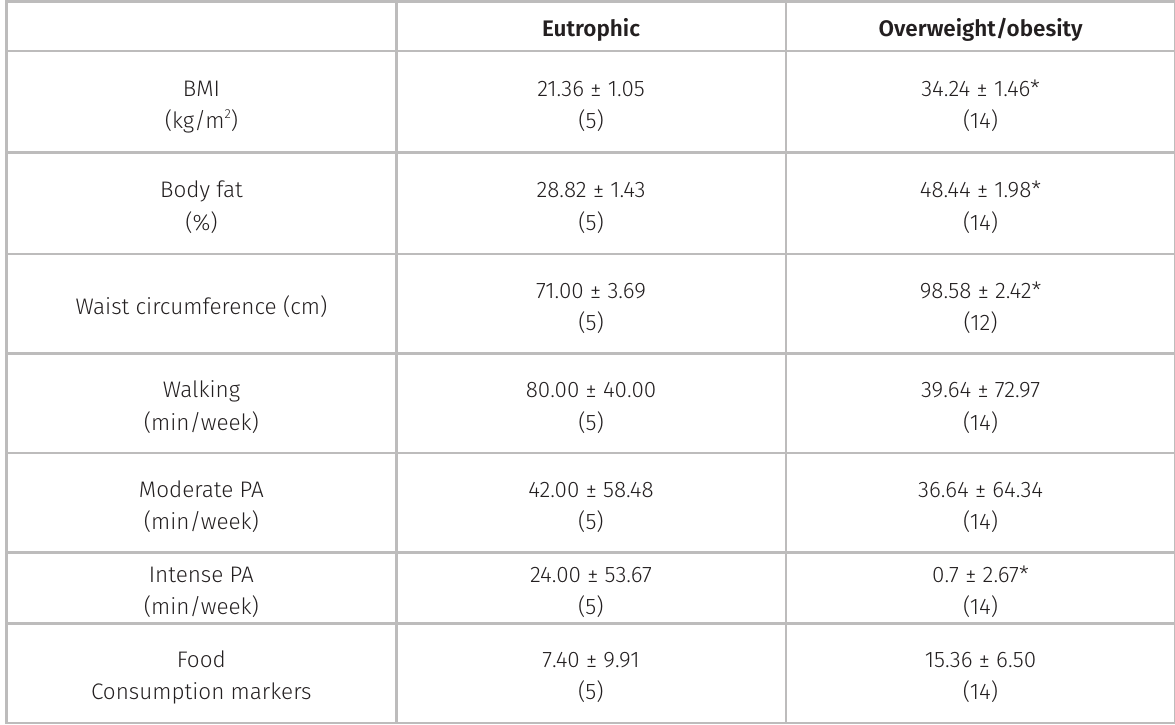
Table I. Participants